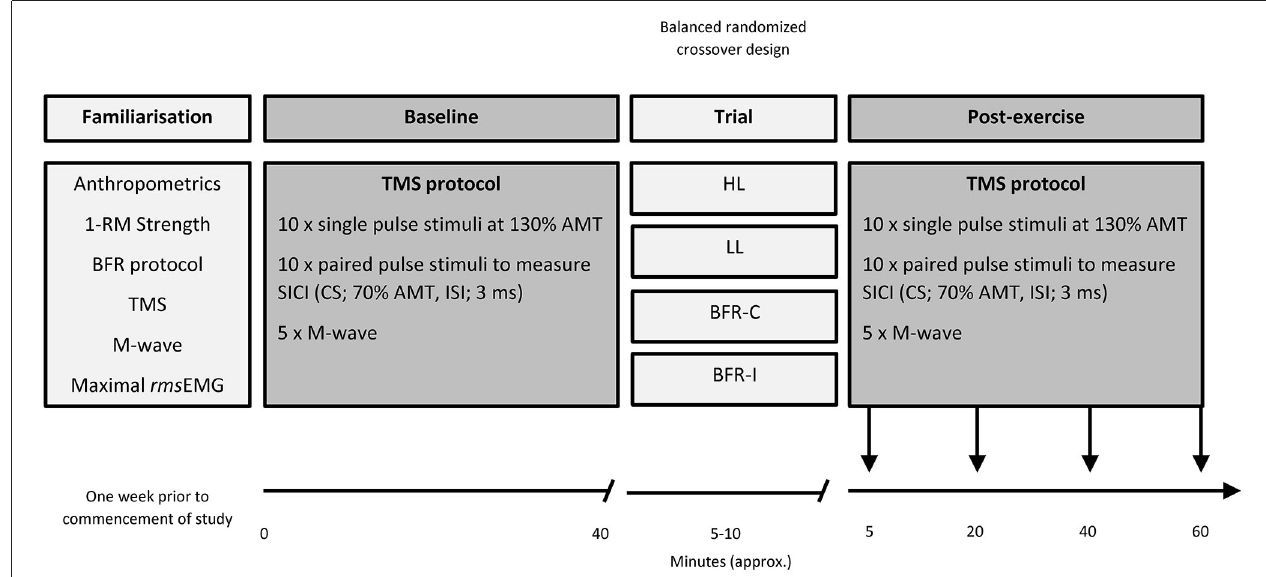
FIGURE 1 | Organization of the study . 1-RM, one repetition maximum; AMT, active motor threshold; BFR-C, continuous blood flow restriction (BFR); BFR-I, intermittent blood flow restriction; CS, conditioning stimulus; HL, heavy-load resistance exercise; ISI, interstimulus interval; LL, light-load resistance exercise; rms EMG, root mean square of the